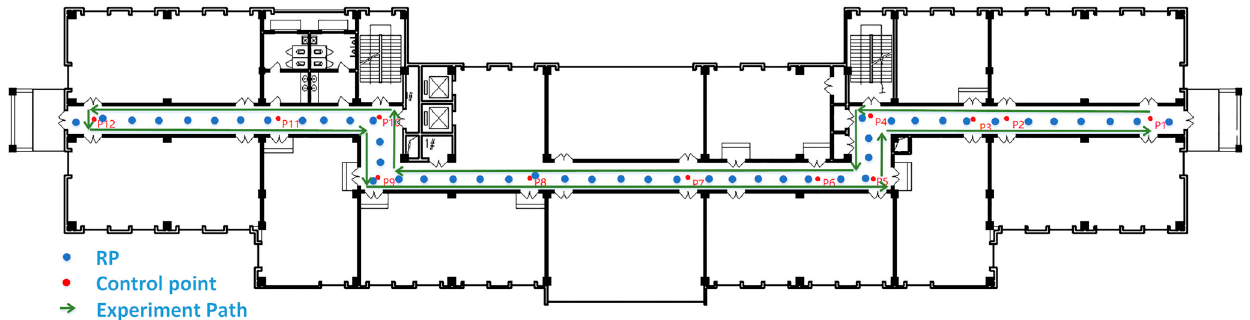
Figure 8. Experimental environment